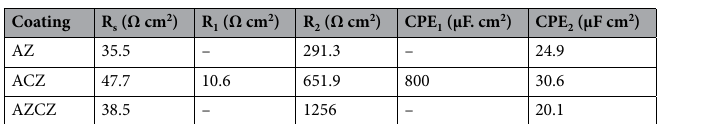
Table 5. Fitting parameters of the equivalent circuit constructed based on EIS